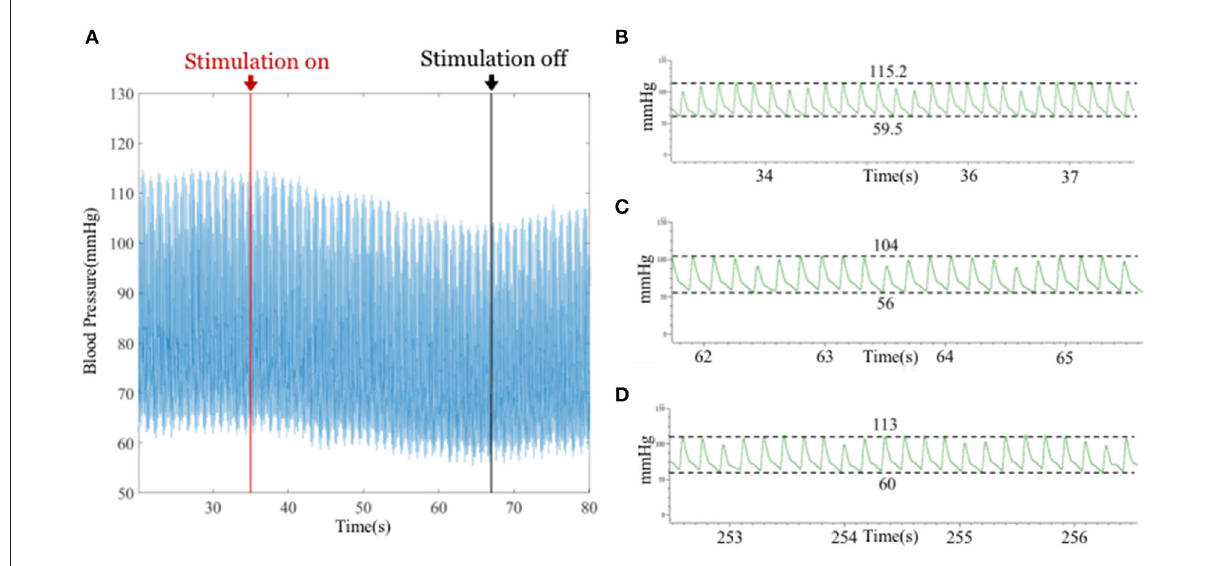
FIGURE10 (A) Change in blood pressure before and after stimulation. The red arrow indicates the start of stimulation, and the black arrows indicate off-stimulation. (B) Blood pressure of rats before electrical stimulation (DBP = 59.5 mmHg, SBP = 115.2 mmHg). (C) Blood pressure of rats after the 30s of electrical stimulation (DBP ≈ 56 mmHg, SBP ≈ 104 mmHg). (D) Blood pressure of rats 180s after electrical stimulation stopped (DBP ≈ 60 mmHg, SBP ≈ 113